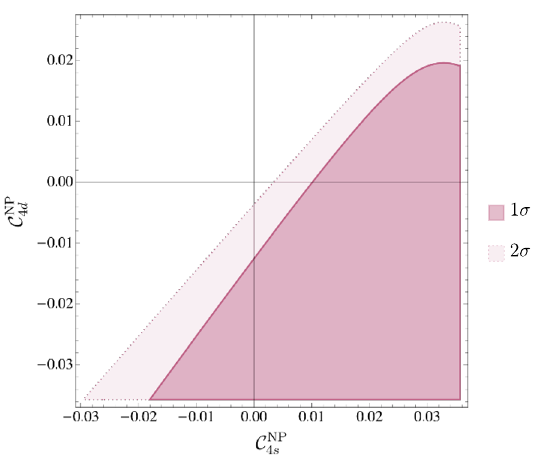
Figure 2 . 1 σ and 2 σ CL regions from L